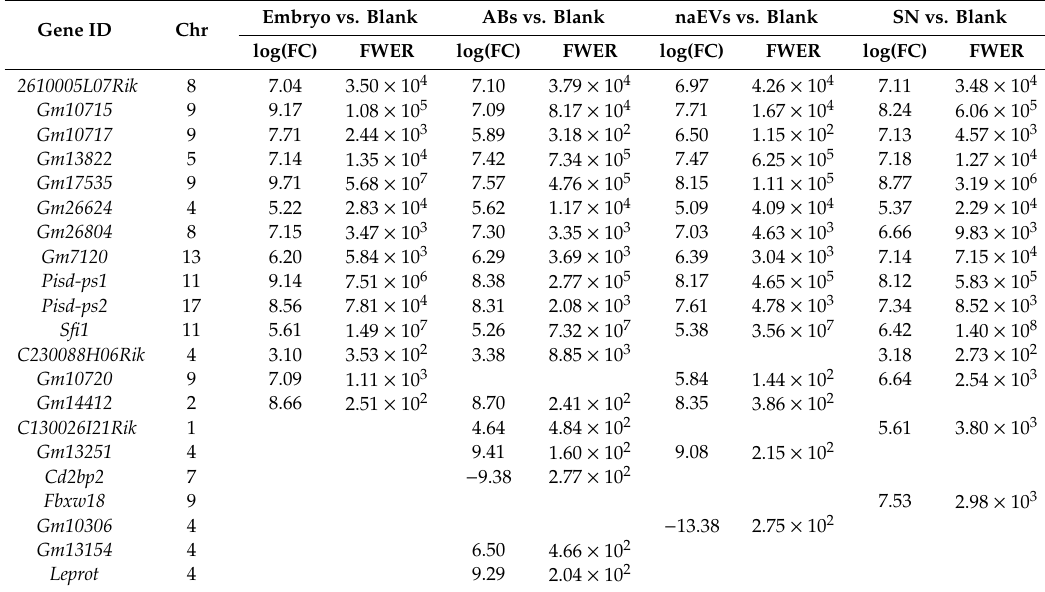
Table 1. Genes enriched in the comparison of the di ff erent DNase untreated samples (embryo, ABs, naEVs and SN) against the blank culture medium.